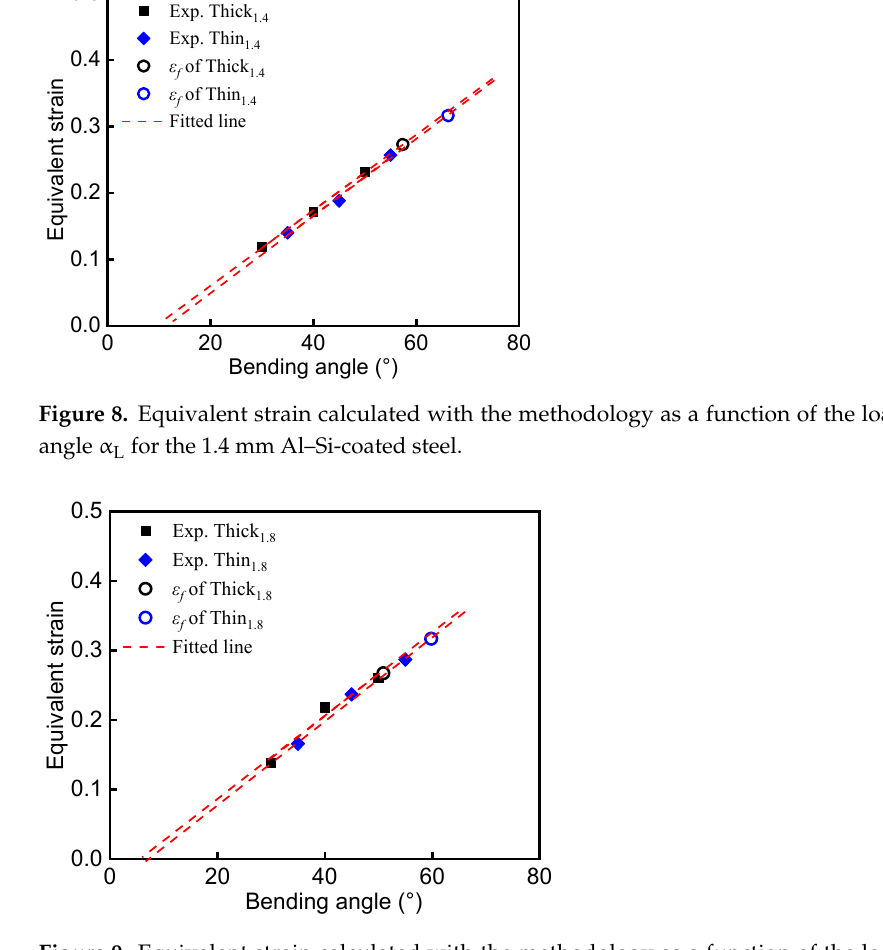
Figure 9. Equivalent strain calculated with the methodology as a function of the loaded bending angle α L for the 1.8 mm Al–Si-coated steel.